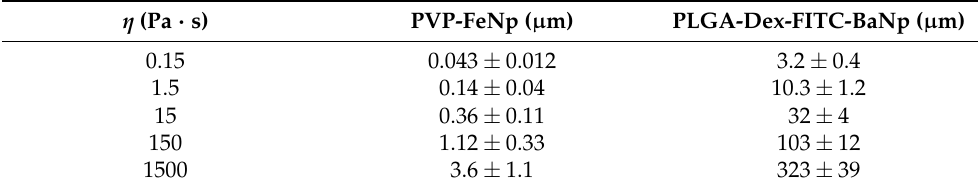
Table 2. Viscosity estimates for corresponding MNP aggregate radii in human tracheobronchial epithelial (NHTE) cell mucus when exposed to the magnetic field. For each given value of η , aggregate radii R for polyvinylpyrrolidone coated Fe 3 O 4 nanoparticles (PVP-FeNPs) and